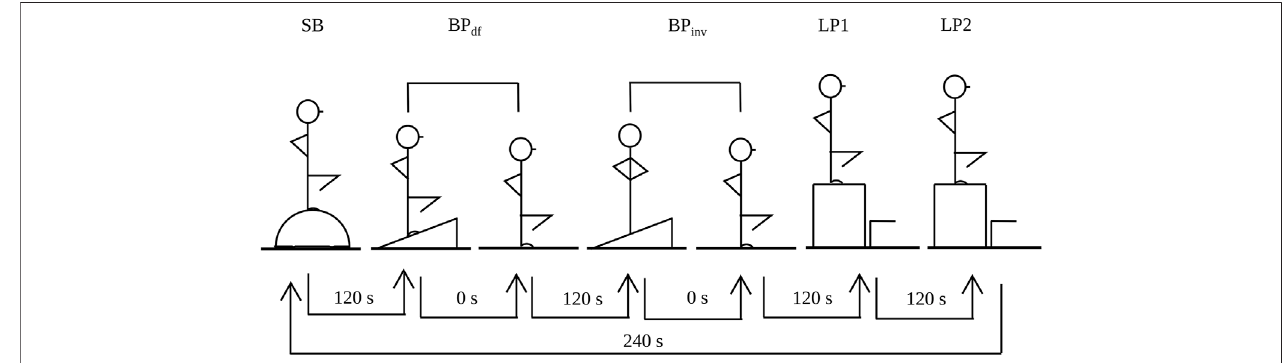
FIGURE 1 | Experimental protocol to compare the acute effects of single leg landings on balance board the top of which tilted into randomized vs. blocked directions on static balance and postural adjustment. SB, static balance test, BP df , balance perturbation test in ankle dorsi fl exion, BP inv , balance perturbation test in ankle inversion, LP, landing practice (either random or